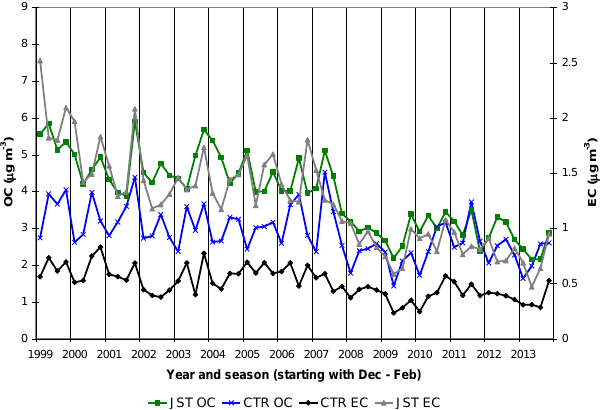
Figure 1. Seasonal mean EC and OC concentrations at CTR and JST. All correlations among the four time series are statistically sig- nificant ( p <0.05): CTR EC and OC, r = 0 . 68 (95% CI 0.52–0.80); JST EC and OC, r = 0 . 87 (95% CI 0.79–0.92); CTR EC and JST EC, r = 0 . 76 (95% CI 0.62–0.85); CTR OC and JST OC, r = 0 . 68 (95% CI